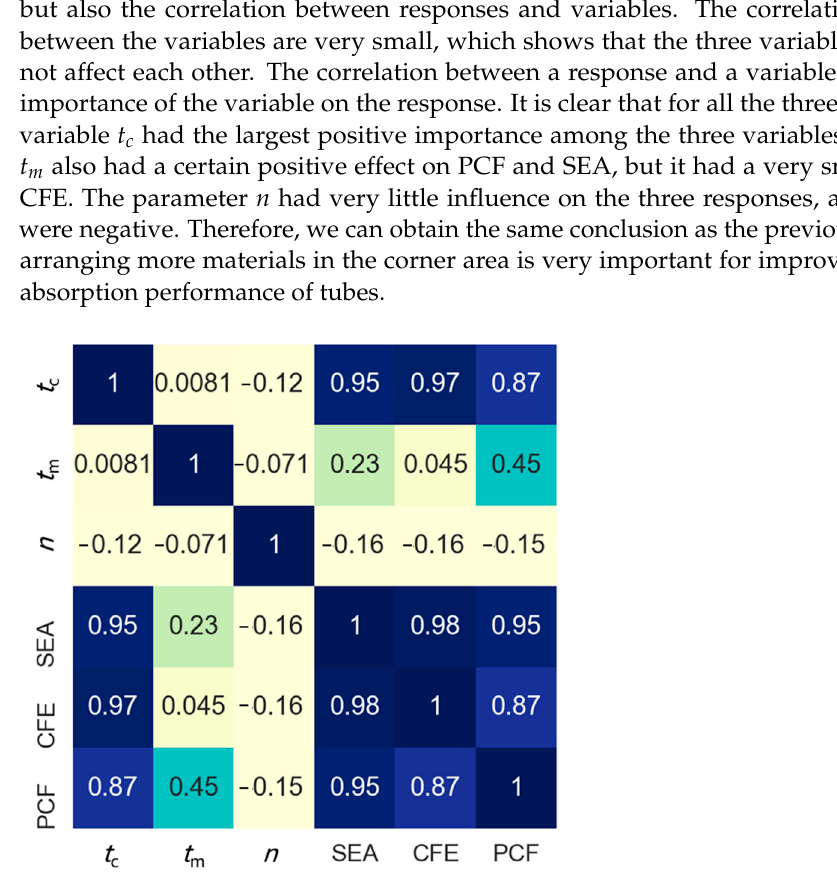
Figure 9. Correlation matrix of the considered variables and responses.